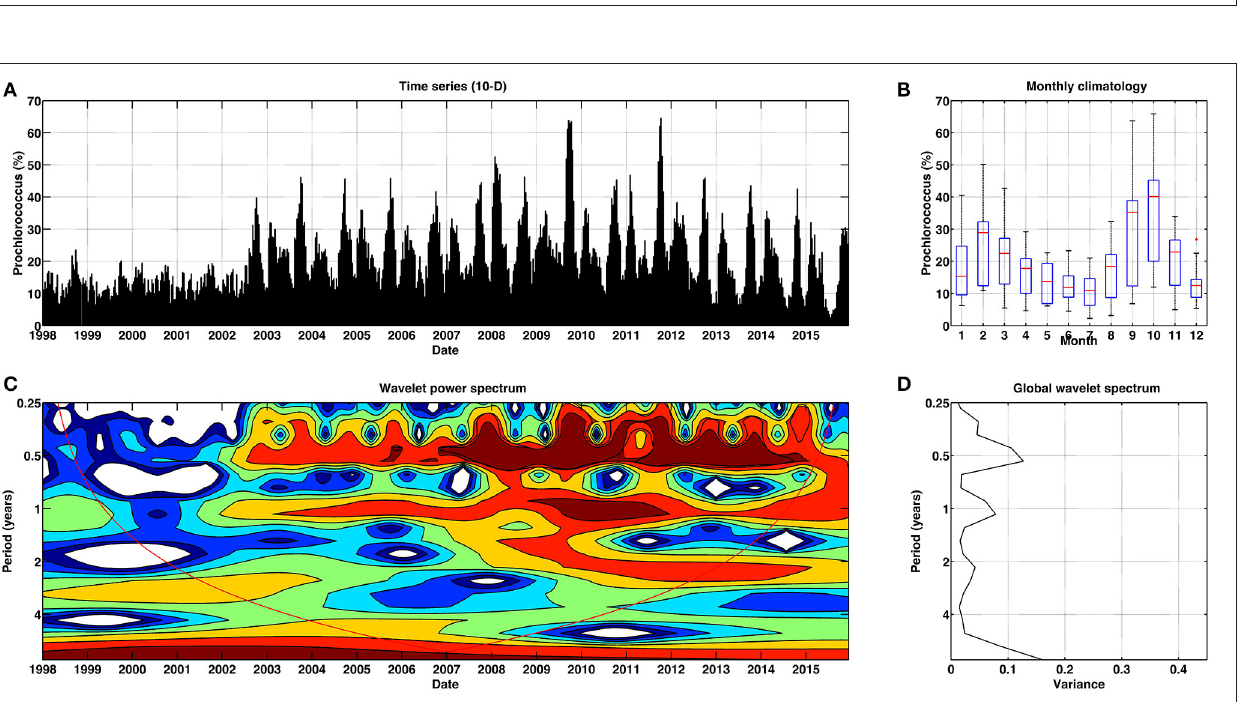
FIGURE 8 | Temporal patterns of variability for Prochlorococcus for Mediterranean Sea. (A) Temporal percentage (10-day) of Prochlorococcus . (B) Box plot (red lines stand for the median, blue box spans from the first to the second quartiles, and black lines represent 5th and 95th percentiles, respectively) of monthly climatology of Prochlorococcus . (C) Continuous wavelet power spectrum for the 10-day time series. Red line indicates the cone of influence, and is the region affected by the edges of the data and should not be considered. (D) Global wavelet spectrum for the 10-day time series.